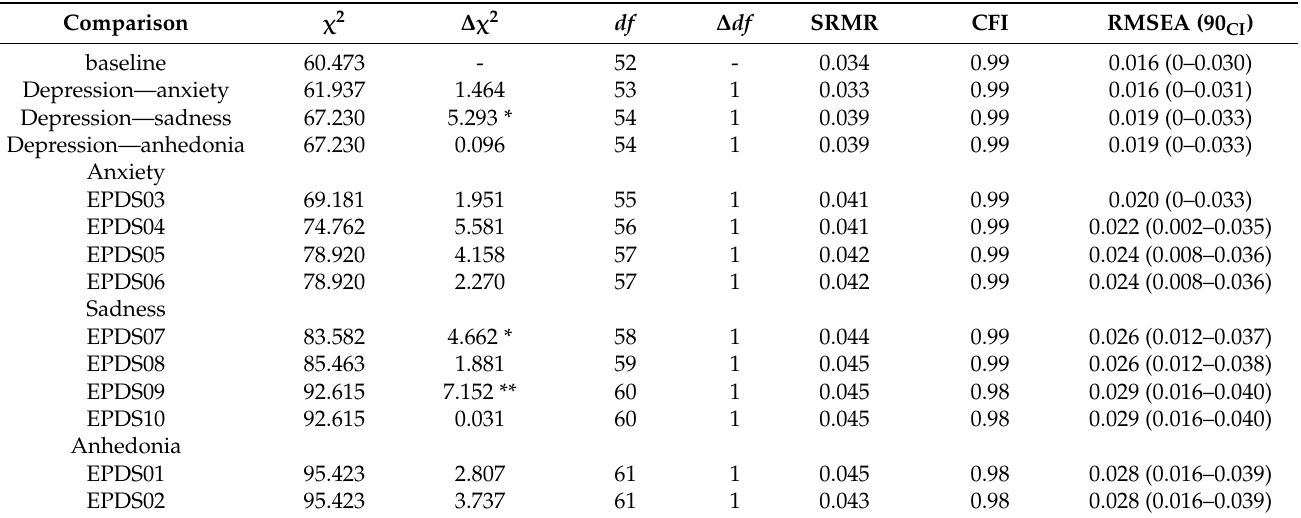
Table 3. Invariance analyses of depressive symptoms—pregnancy and post-birth, Bedouin women in